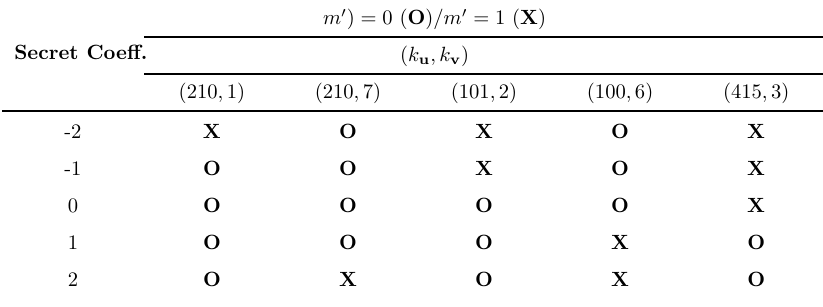
Table 4: Value of the decrypted message m 0 as a function of the chosen values for the ordered pair ( k u , k v ) and the targeted secret coefficient, used for our attack on the KYBER512 variant of Kyber CCA-secure KEM. While O refers to the case of m 0 = 0, X refers to m 0 =